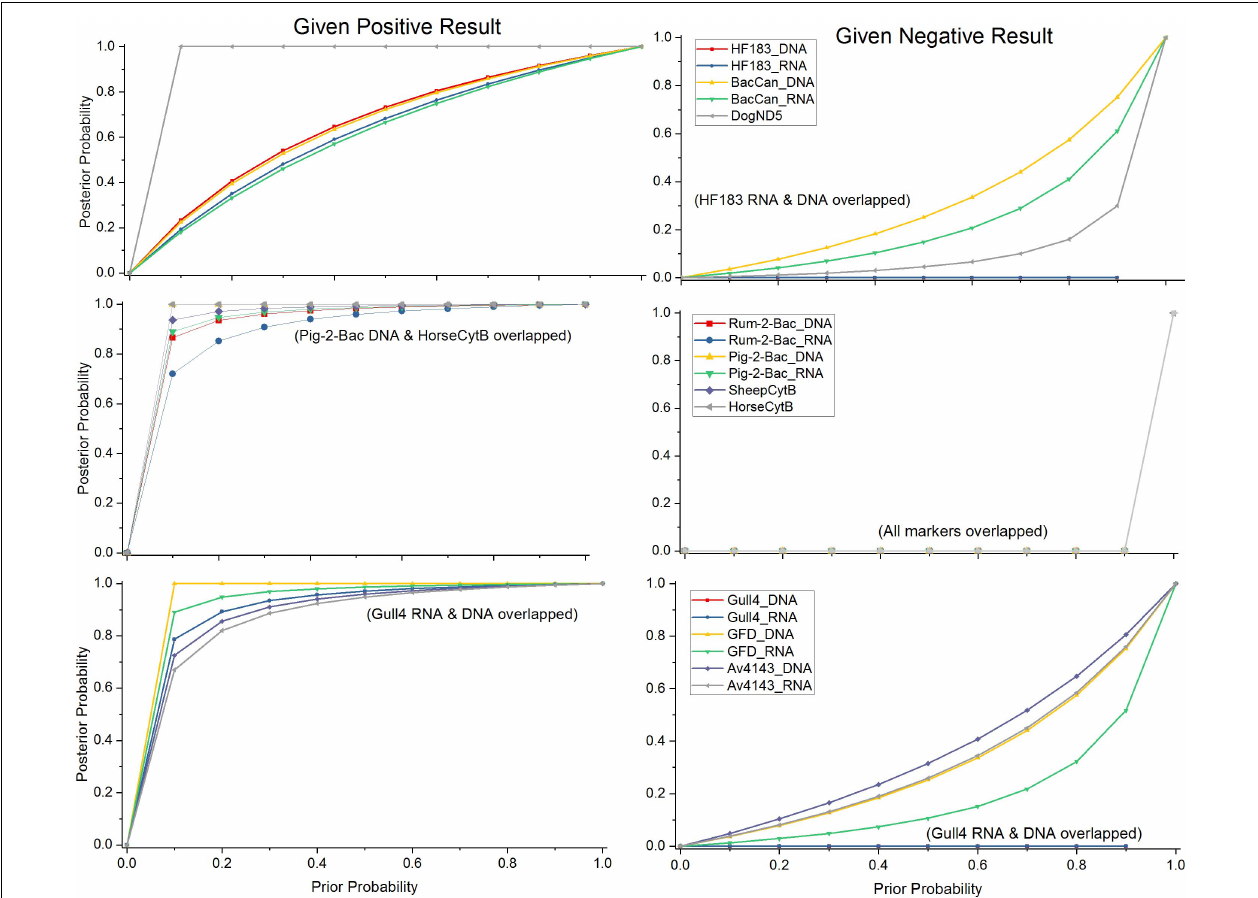
FIGURE 5 | The probabilities of true-positive and false-negative results in the case of animal fecal contamination by the Bayesian statistical model. Posterior probabilities of contamination given a positive qPCR result using the markers specific for dog, sheep, and bird, as well as human, gull, horse, and swine over a range of prior